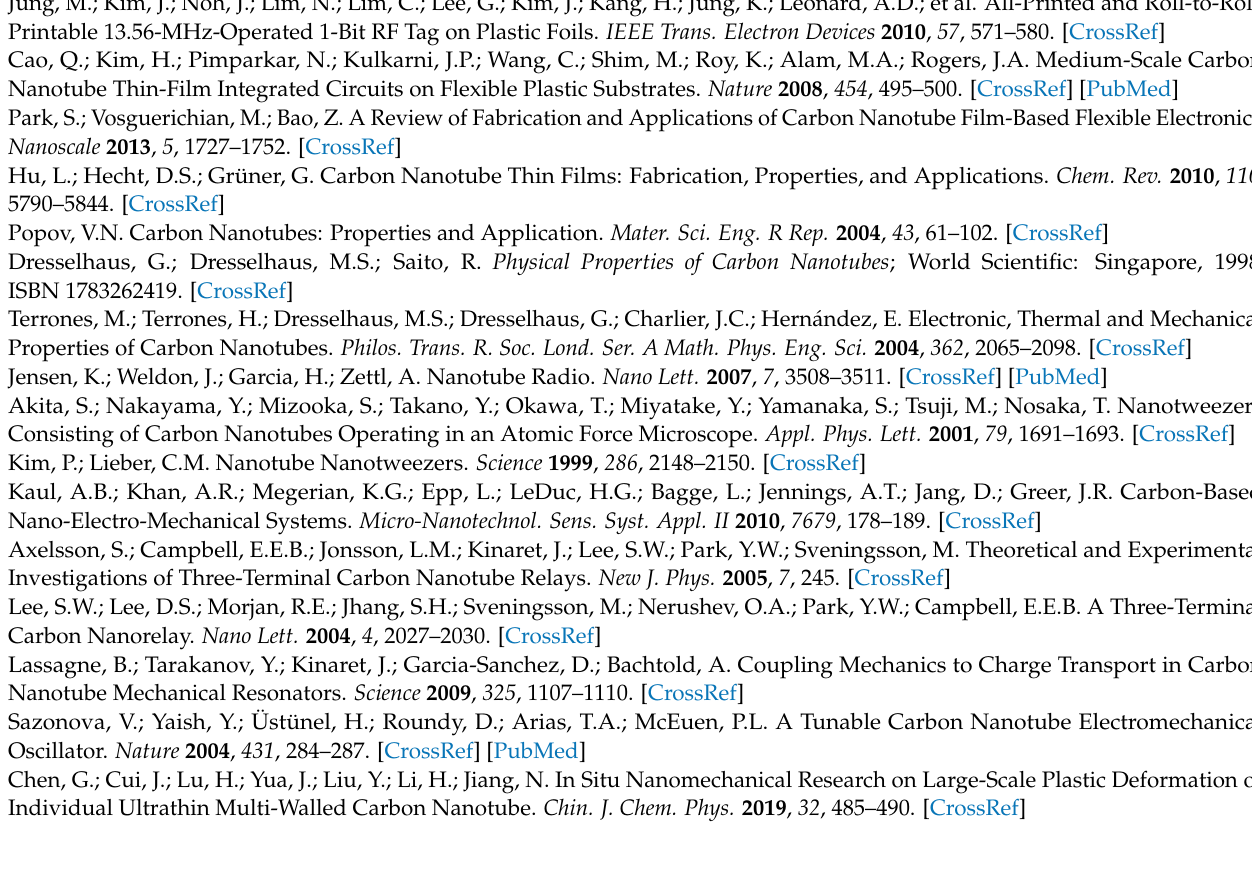
Figure S2: SEM images of silicon sedge substrates; Figure S3: SEM images of the grown VACNTs; Figure S4: TEM image of the targeted VACNT prior to mechanical testing; Figure S5: Validation of the critical force for buckling. Video S1: In situ TEM compression experiment-cycle 8 (1000 nm maximum displacement). References [40,59] are cited in the supplementary